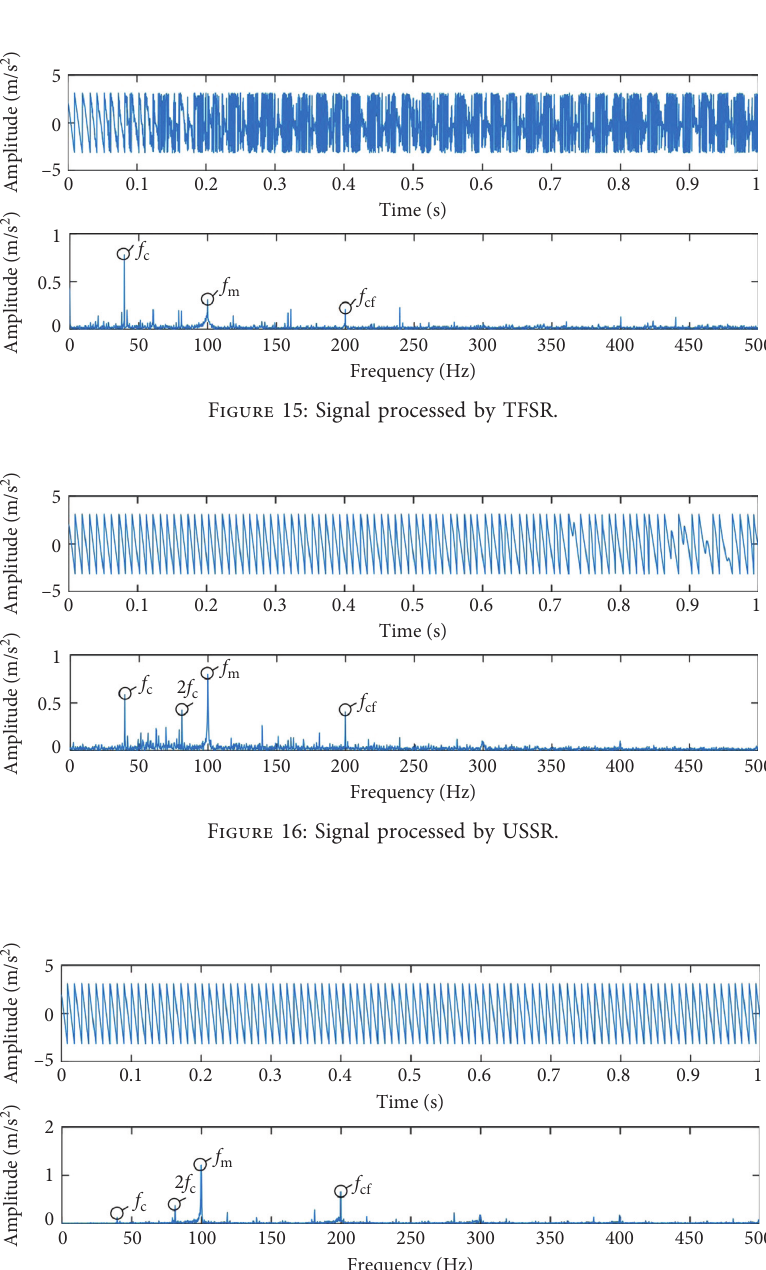
Figure 17: Signals processed by USAGVSR.